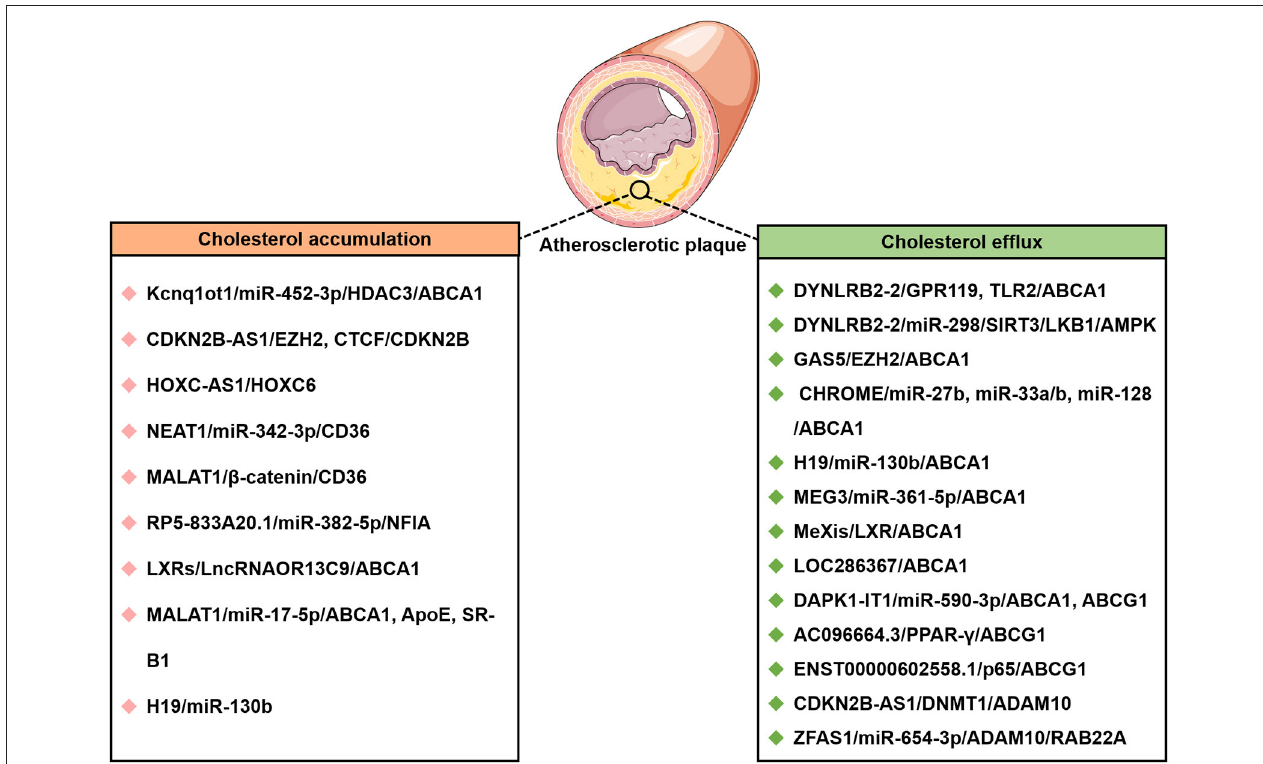
FIGURE 2 | The lncRNAs affect cholesterol accumulation and cholesterol efflux from THP-1 macrophage-derived foam cells in atherosclerotic disease. CTCF, CCCTC-binding factor; DNMT1, DNA methyltransferase 1; EZH2, enhancer of zeste homolog 2; HOXC-AS1, lncRNA HOXC cluster antisense RNA 1; Kcnq1ot1, Kcnq1 overlapping transcript 1; LncRNA MAARS, Macrophage-Associated Atherosclerosis lncRNA Sequence; NFIA, nuclear factor